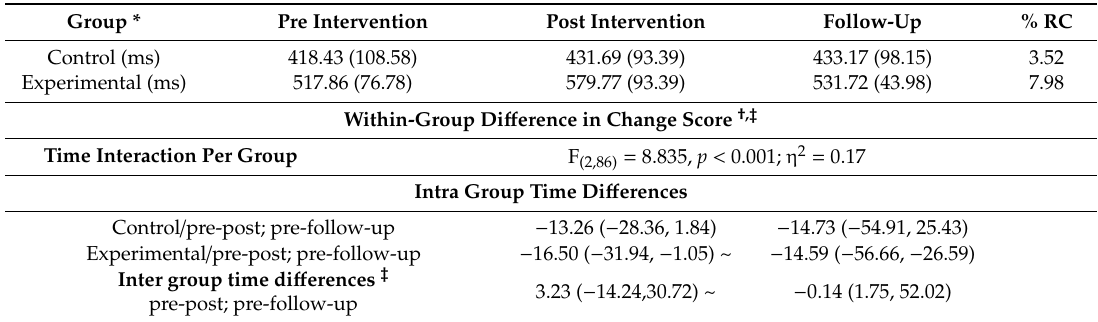
Table 3. Flight time intra- and inter-group di ff